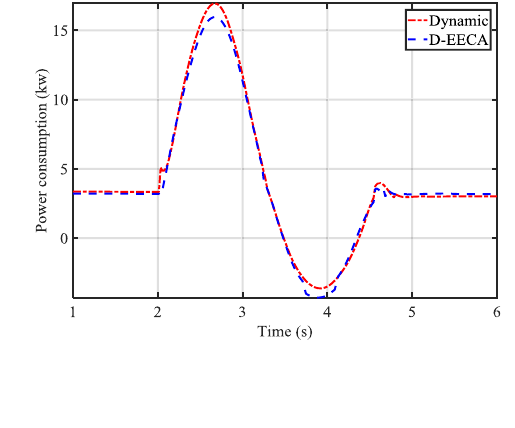
Figure 10 The longitudinal velocity of A-IWMs EV and tracking errors